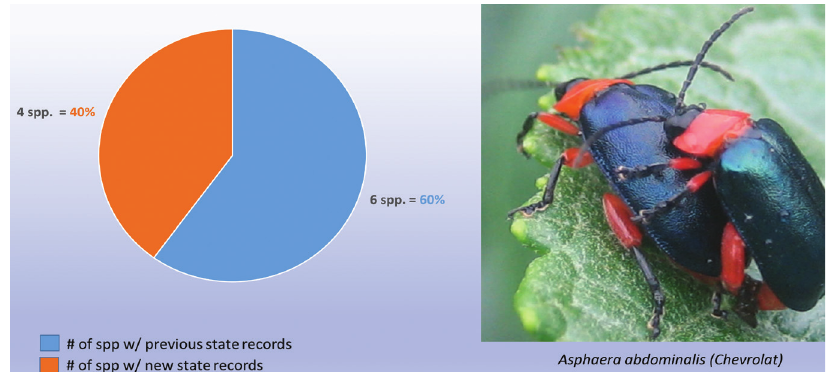
Figure 2. Asphaera Chevrolat new state records versus previously recorded state records.